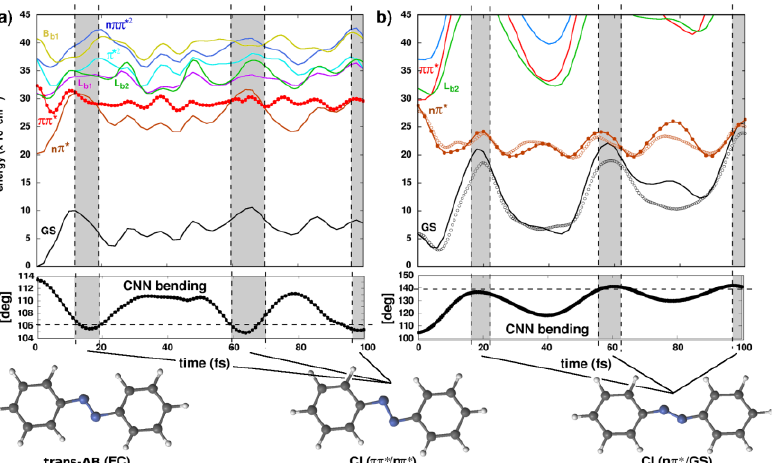
Fig. 2. Structure of the excited state manifold up to 45 kcm -1 along the molecular dynamics in the ππ* state (red) initiated at the FC point (a) and along the nπ* state (brown) initiated at the CI ( ππ* / nπ*)